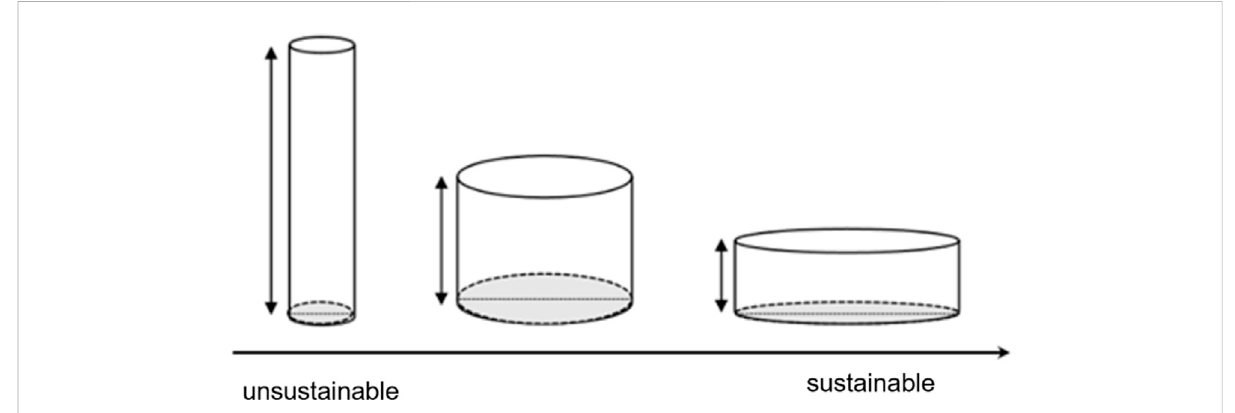
FIGURE 2 The relationship between three-dimensional ecological footprint and sustainable development.